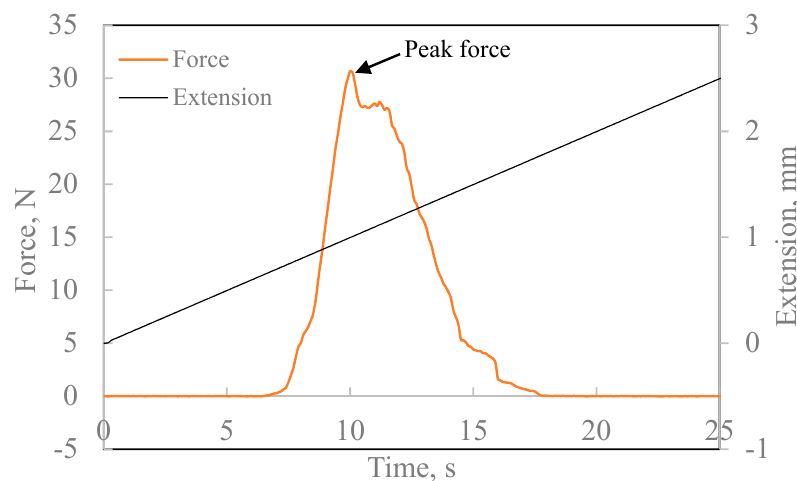
Figure 1. Force deformation curve and extension.